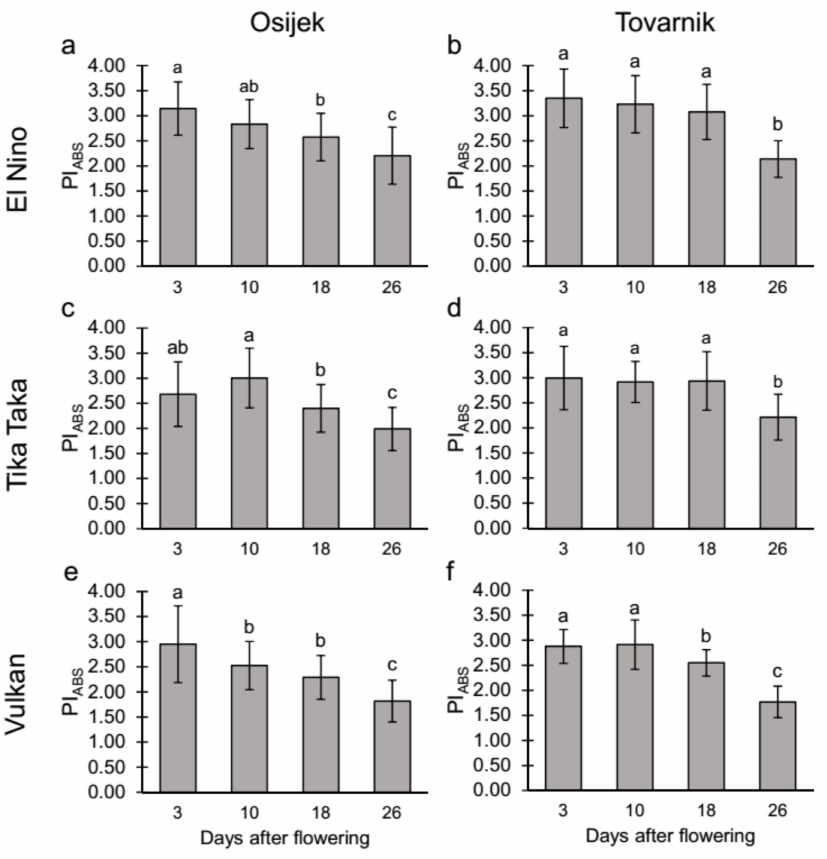
Figure 5. Performance index (PI abs ) presented as mean value ± standard deviation of 20 flag leaves of variety El Nino ( a , b ), Tika Taka ( c , d ), and Vulkan ( e , f ) through four measurement points at two locations separately (Osijek and Tovarnik). Standard deviations are presented as vertical bars. Lower- case letters above columns are used to present results of statistical data analysis obtained by Fisher’s LSD test and point to statistically significant difference ( p < 0.05) between values of PI abs measured at 3, 10, 18, and 26 days after flowering for each wheat variety separately and at each